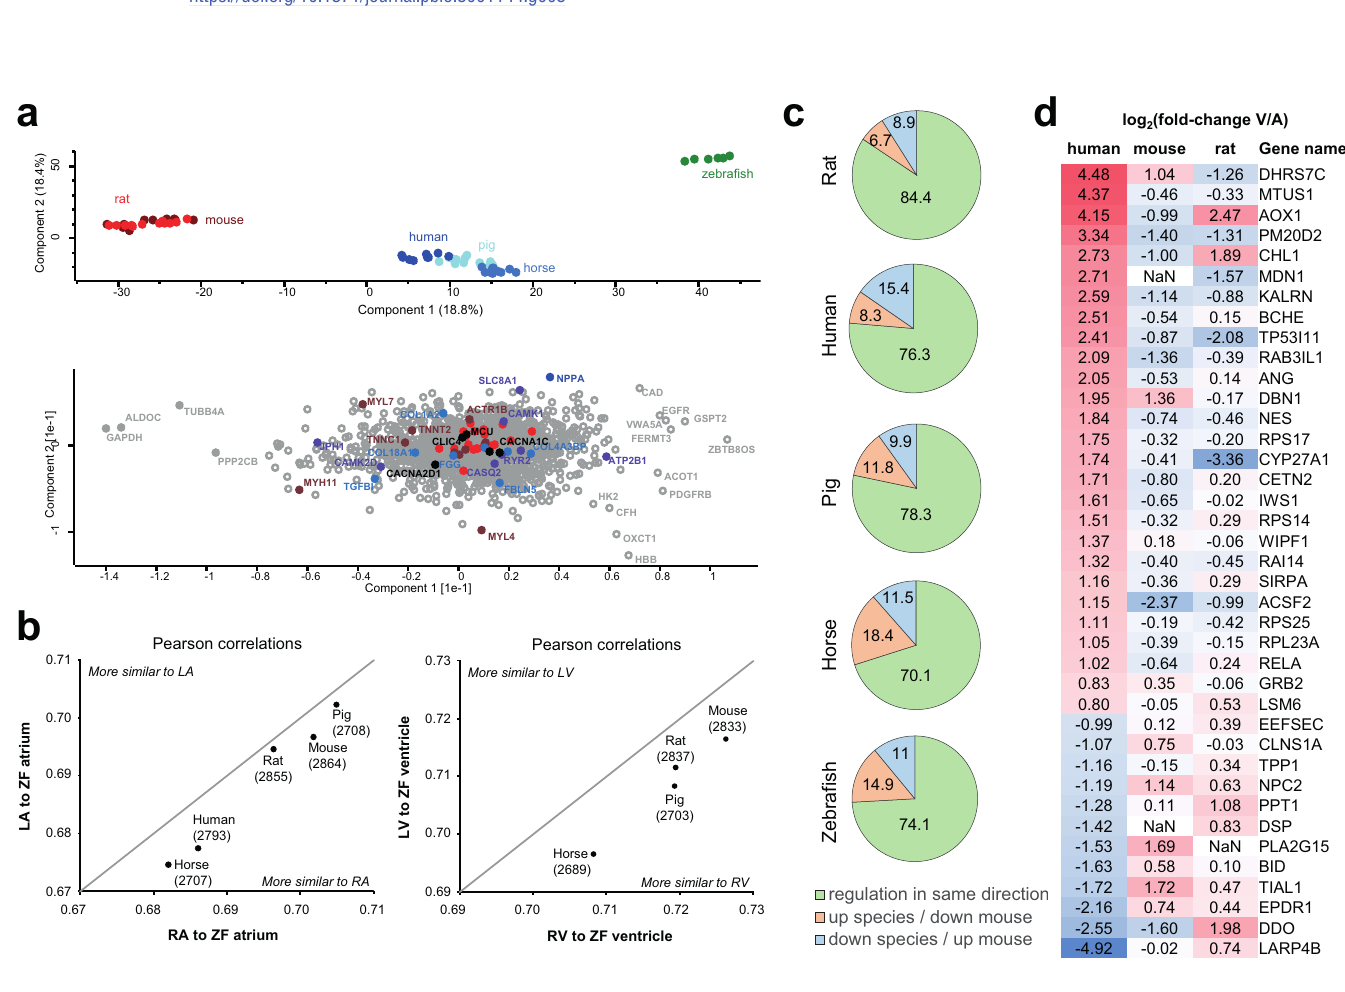
Fig 3. Protein abundance profiles across species. (a) Unsupervised hierarchical clustering of normalized protein intensities, for proteins measured in all samples resulted in grouping of samples from the same organism and reflects evolutionary distance between species as well as specific similarities and differences in protein expression. Proteins are colored by intensity with red showing highest and blue showing lowest intensity values (color bar denotes log2-transformed normalized protein intensities). (b) Visual representation of GO enrichment analysis of proteins with significantly different (upper panel) or similar (lower panel) abundance profiles across all species. Shown are representative enriched terms for GO, BP, CC, and MF, as well as KEGG pathways. Sizes of boxes are proportional to − log10 ( p -value) of the enrichment (the larger, the more significant), and numbers denote the number of proteins enriched in the respective category. BP, biological process; CC, cellular component; GO, gene ontology; KEGG, Kyoto Encyclopedia of Genes and Genomes; MF, molecular function.